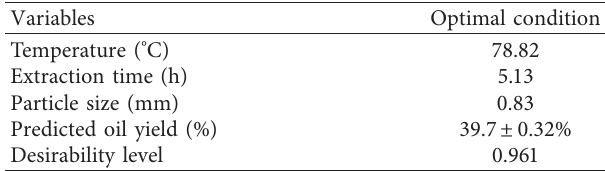
Figure 4: Interaction influence of extraction time and temperature on MSO yield, 3D surfaces plot. (b) Contour plots. Table 5: The numerical solution to achieve maximized MSO